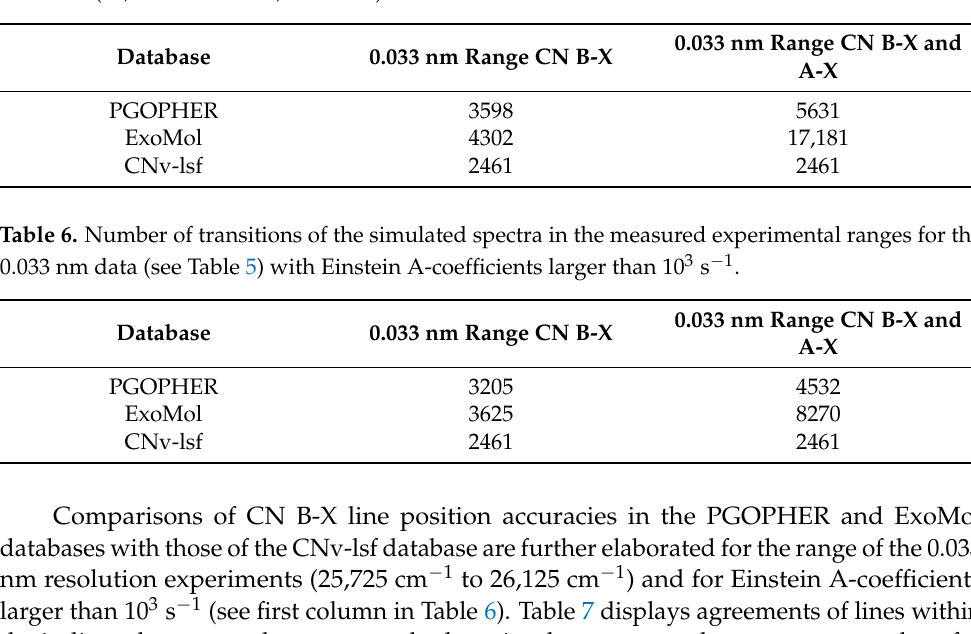
Table 5. Number of transitions of the simulated spectra in the measured experimental ranges for the